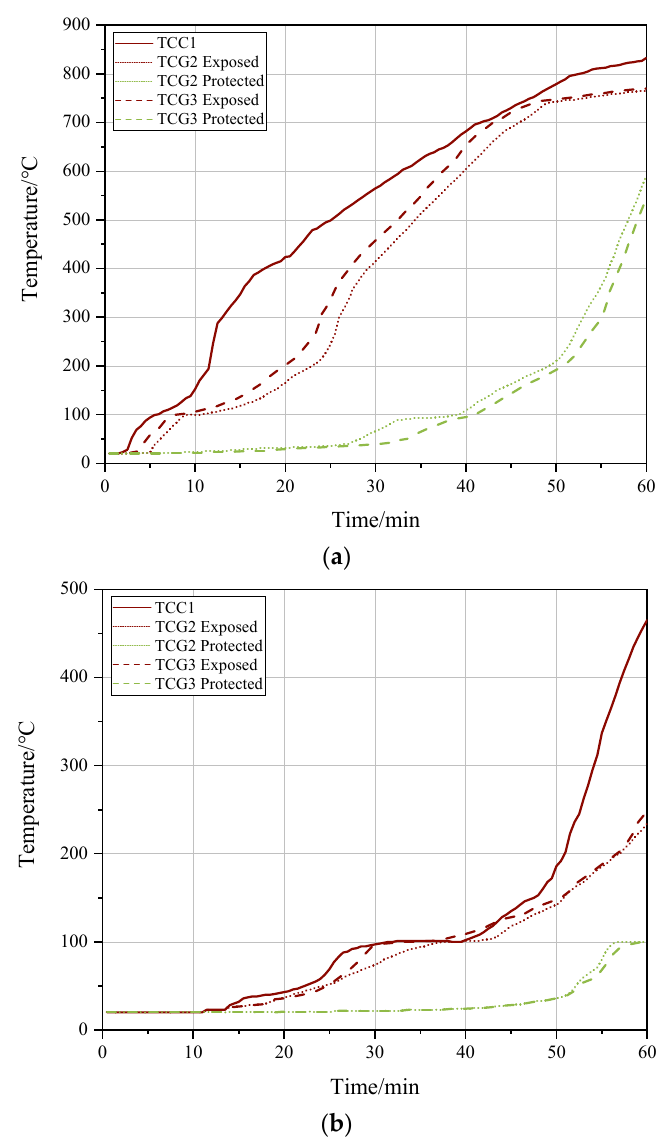
Figure 10. Temperature–time curves of the measuring points under fire: ( a ) 10 mm; and ( b ) 35 mm.